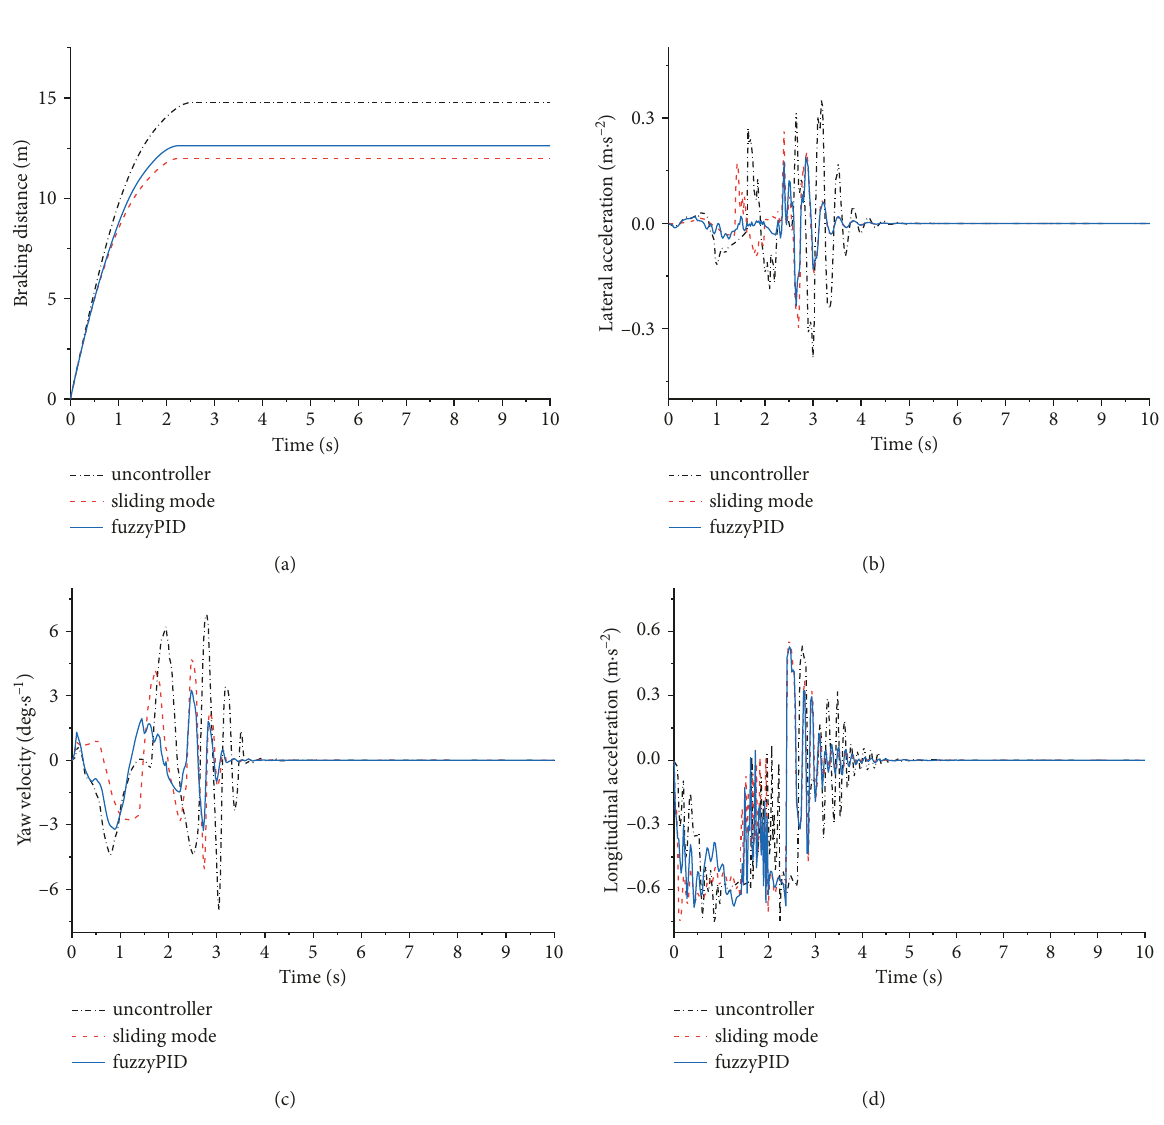
Figure 19: Simulation diagram of curve driving with long downhill braking efficiency of 100% at u � 0.75. (a) Braking distance. (b) Lateral acceleration. (c) Yaw velocity. (d) Longitudinal